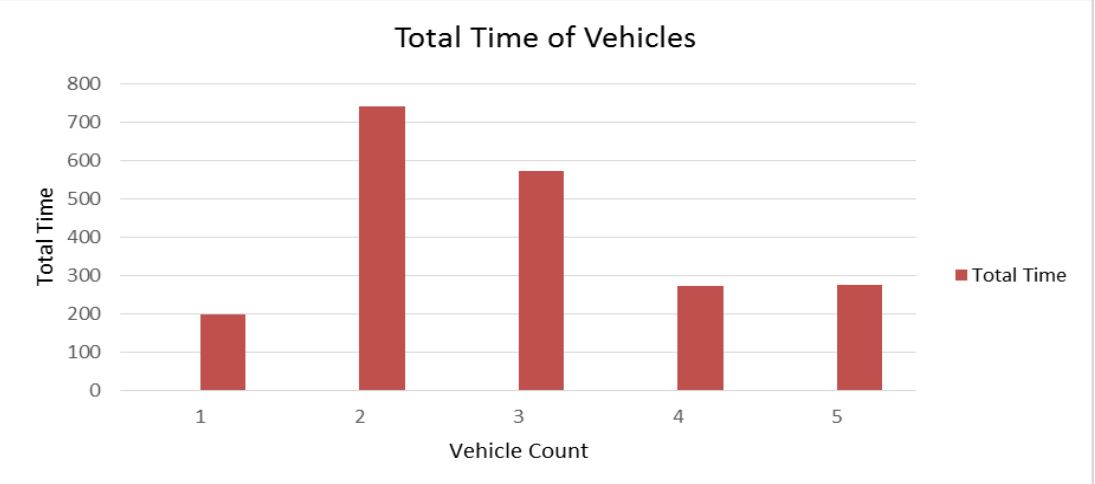
Figure 18. Total Time of Vehicles